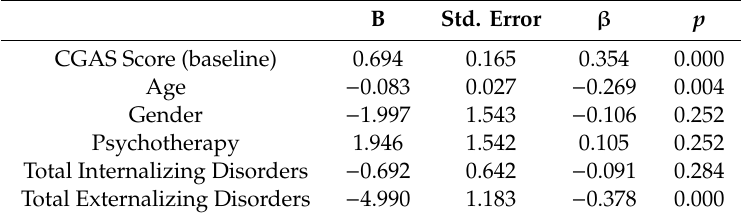
Table 7. Linear regression model with CGAS scores (6th month) as the dependent variable. B Std.